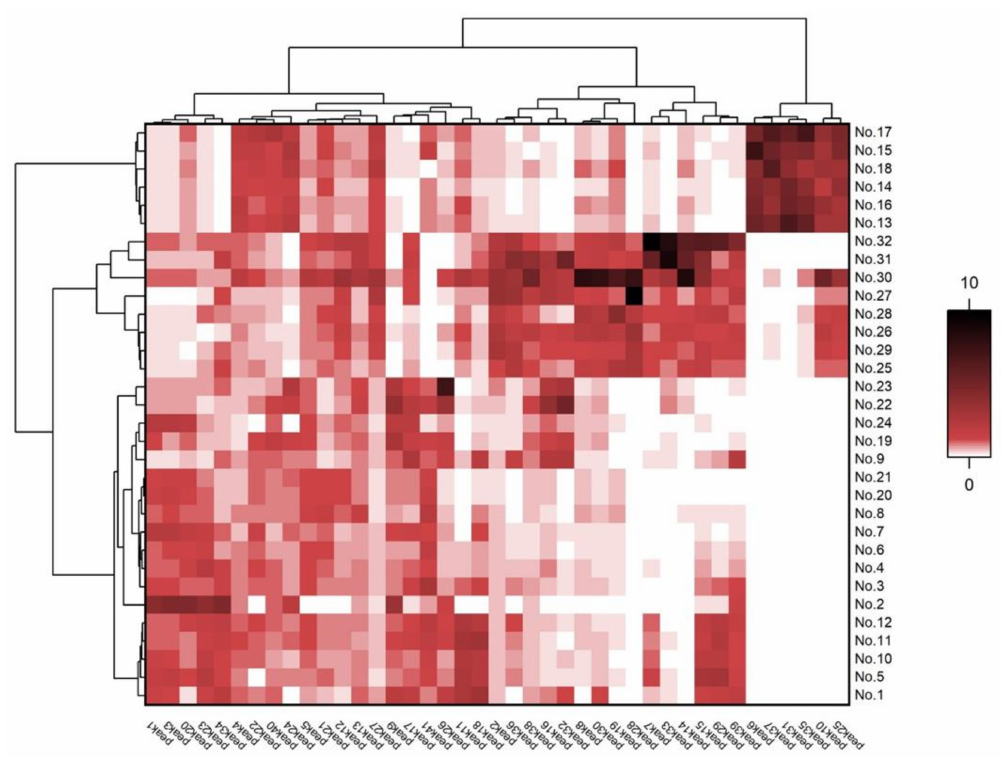
Figure 3. Hierarchical clustering analysis (HCA) with a heatmap from original and mutant cultivars of Coreopsis